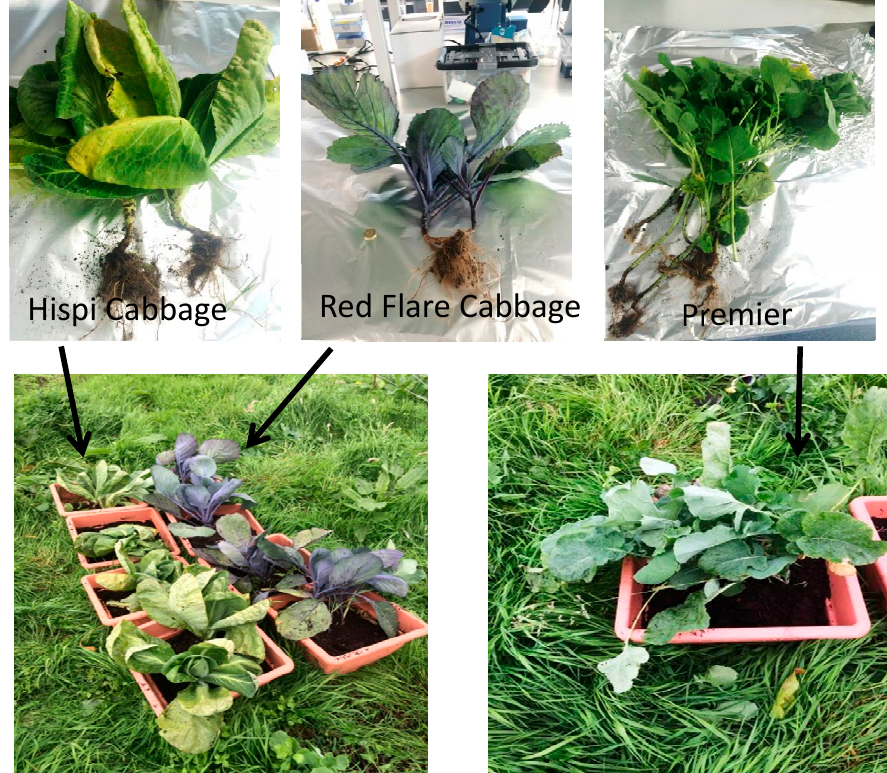
Figure A7. Photographs of the selenium non-accumulator plants (pasture species) collected for sam- pling for chemical and XAS analyses. Samples of tall fescue grass with minor necrosis of the leaves and white clover.